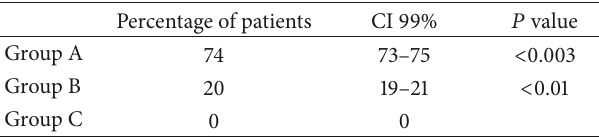
Table 2: Tonic-clonic seizure in patients of each group, referred to Imam Reza (AS) Hospital in